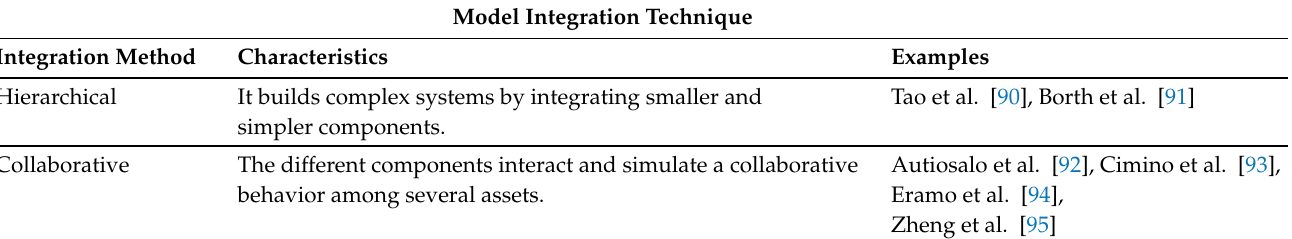
Table 3. Sample model integration